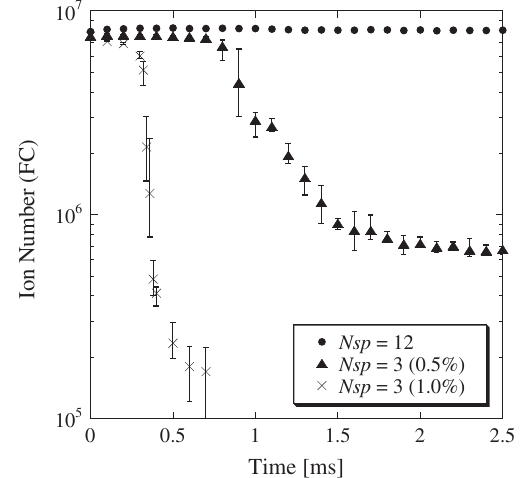
FIG. 8. Time evolution of the experimentally measured ion number confined in the trap. The amplitude of the primary rf field is fixed at 38.9 V corresponding to (cid:4) 0 (cid:3) 1 : 66 . Circles ( d ) correspond to measurements of the ideal 12-fold symmetric ( N sp ¼ 12 ) case where no perturbation is present. Crosses ( (cid:6) ) and triangles ( m ) represent measurements when the perturbation waves are added to the N sp ¼ 12 primary focusing wave. The amplitude of the N sp ¼ 3 perturbation wave is given relative to the primary-wave